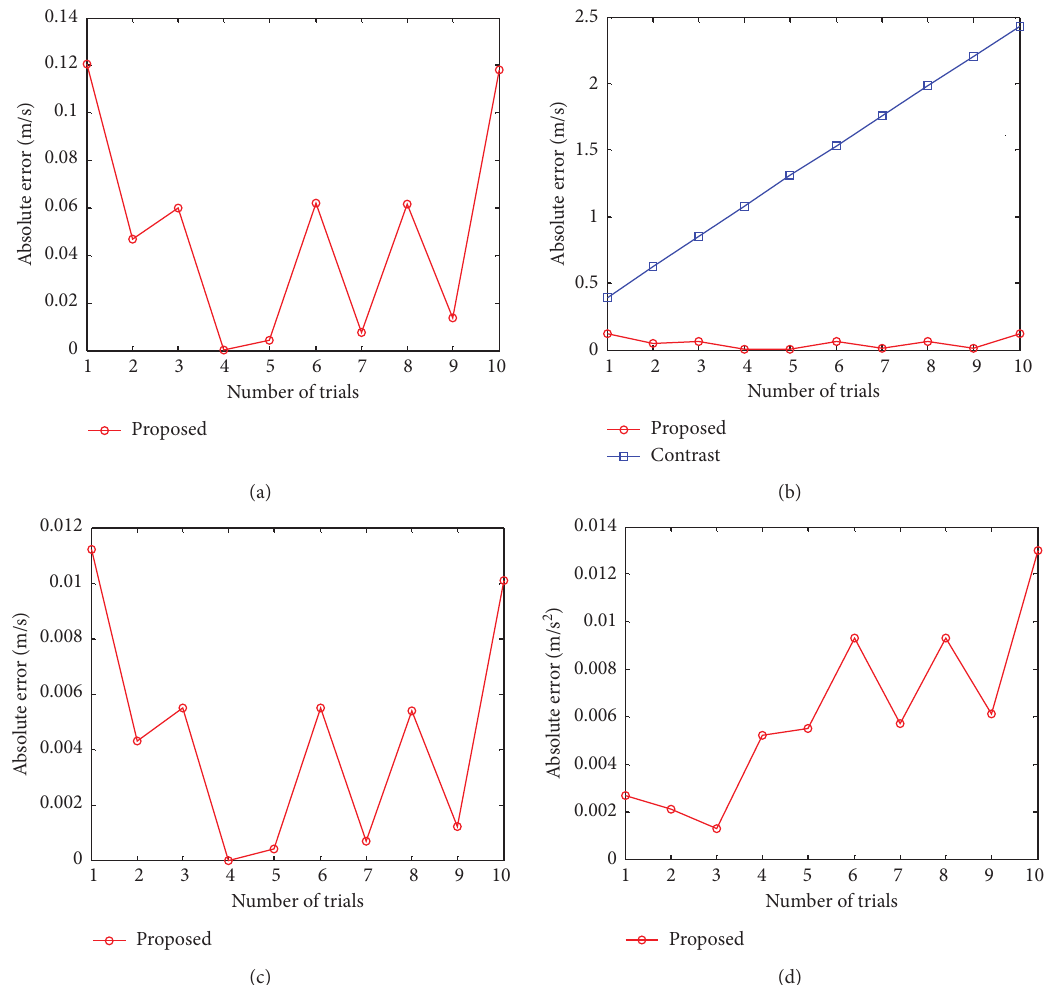
Figure 7: Estimation results as a function of range acceleration varying from 0.01m/s 2 to 0.1m/s 2 at v error in the azimuth velocity estimation using the proposed method, (b) a comparison of the errors from the proposed method and contrast method, (c) absolute error in the range velocity estimation using the proposed method, and (d) absolute error in the range acceleration estimation using the proposed